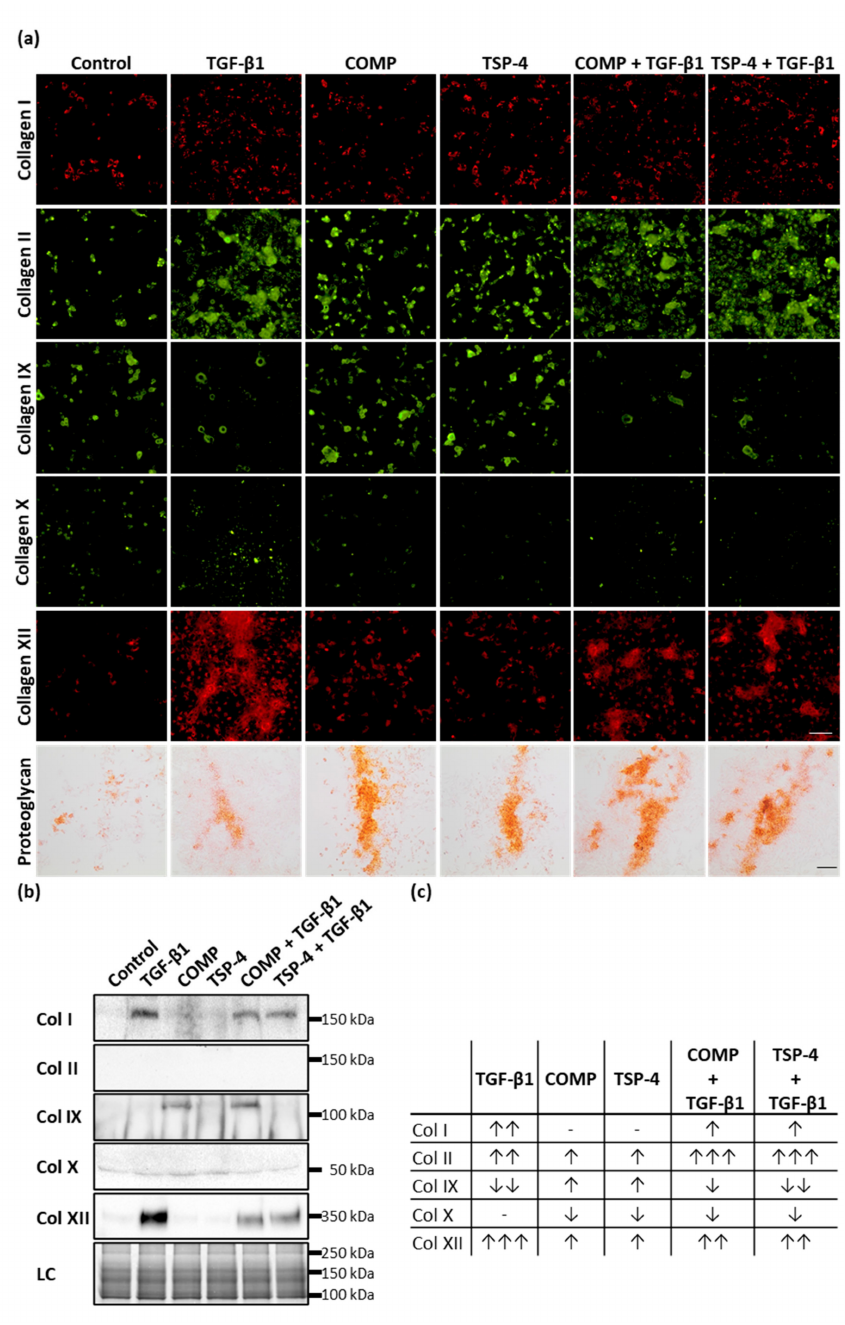
Figure 3. The effect of COMP and TSP-4 on collagen and proteoglycan production and deposition. Chondrocytes were stimulated with COMP (10 µ g/mL), TSP-4 (10 µ g/mL) alone or in combination with TGF- β 1 (0.5 ng/mL) for seven days. ( a ) Immunofluorescence staining of collagen (Col) I, II, IX, X and XII as well as Safranin-O staining of proteoglycans at day 10. ( b ) Immunoblot assays of chondrocyte supernatants at day 10. Roti ® blue staining of proteins was used as a loading control (LC). ( c ) Table summarizing the effect of COMP, TSP-4 and TGF- β 1 on the total amount of different collagen types (matrix-associated and soluble). The amount of matrix-associated collagens was visually scored from IF staining and combined with band intensities for soluble proteins derived from immunoblots. The number of arrows indicates a strong, moderate or mild effect compared to the control. The direction of the arrows indicates an increase ( ↑ ) or decrease ( ↓ ) compared to control. No changes are indicated by a minus. The number of arrows indicates strong (three arrows), moderate (two arrows) or mild (one arrow) changes compared to control. (Immunofluorescence staining, n = 3; immunoblot n ≥ 2 per group); unstimulated cells were used as a control; scale bar (collagens) = 100 µ m; and (proteoglycans) = 200 µ